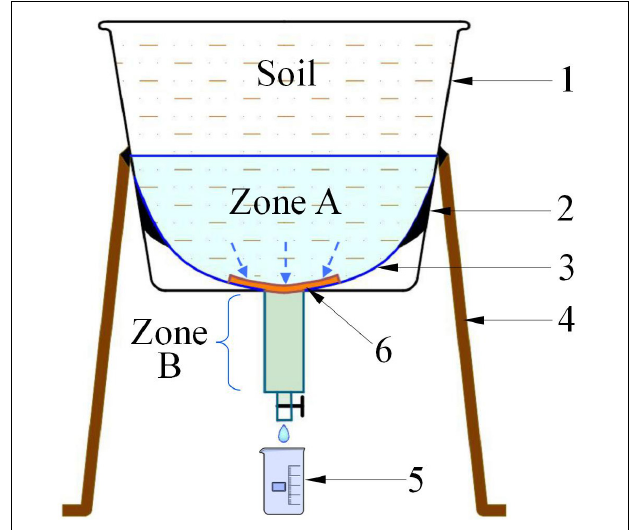
FIGURE 1 | Device for collecting and measuring amount of water seepage under the soil. (A) Is the guiding area of water seepage. (B) Is the collection area of water seepage. 1. Outer barrel; 2. Sealant; 3. Inner barrel; 4. Supporting framework; 5. Measuring cup; 6. Gauze filter.